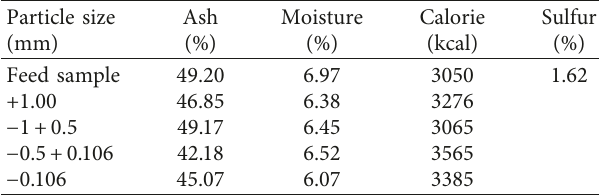
Figure 3: Sample-C2 coal screen analysis graphic. Table 8: Sample-C2 screen analysis: ash, moisture, and calorie